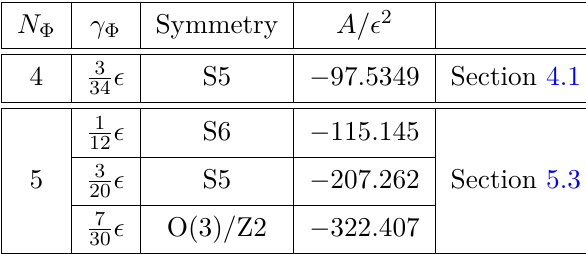
Table 2 . Irreducible fixed points of N Φ =4 and N Φ =5. The N=4 fixed point listed here is the